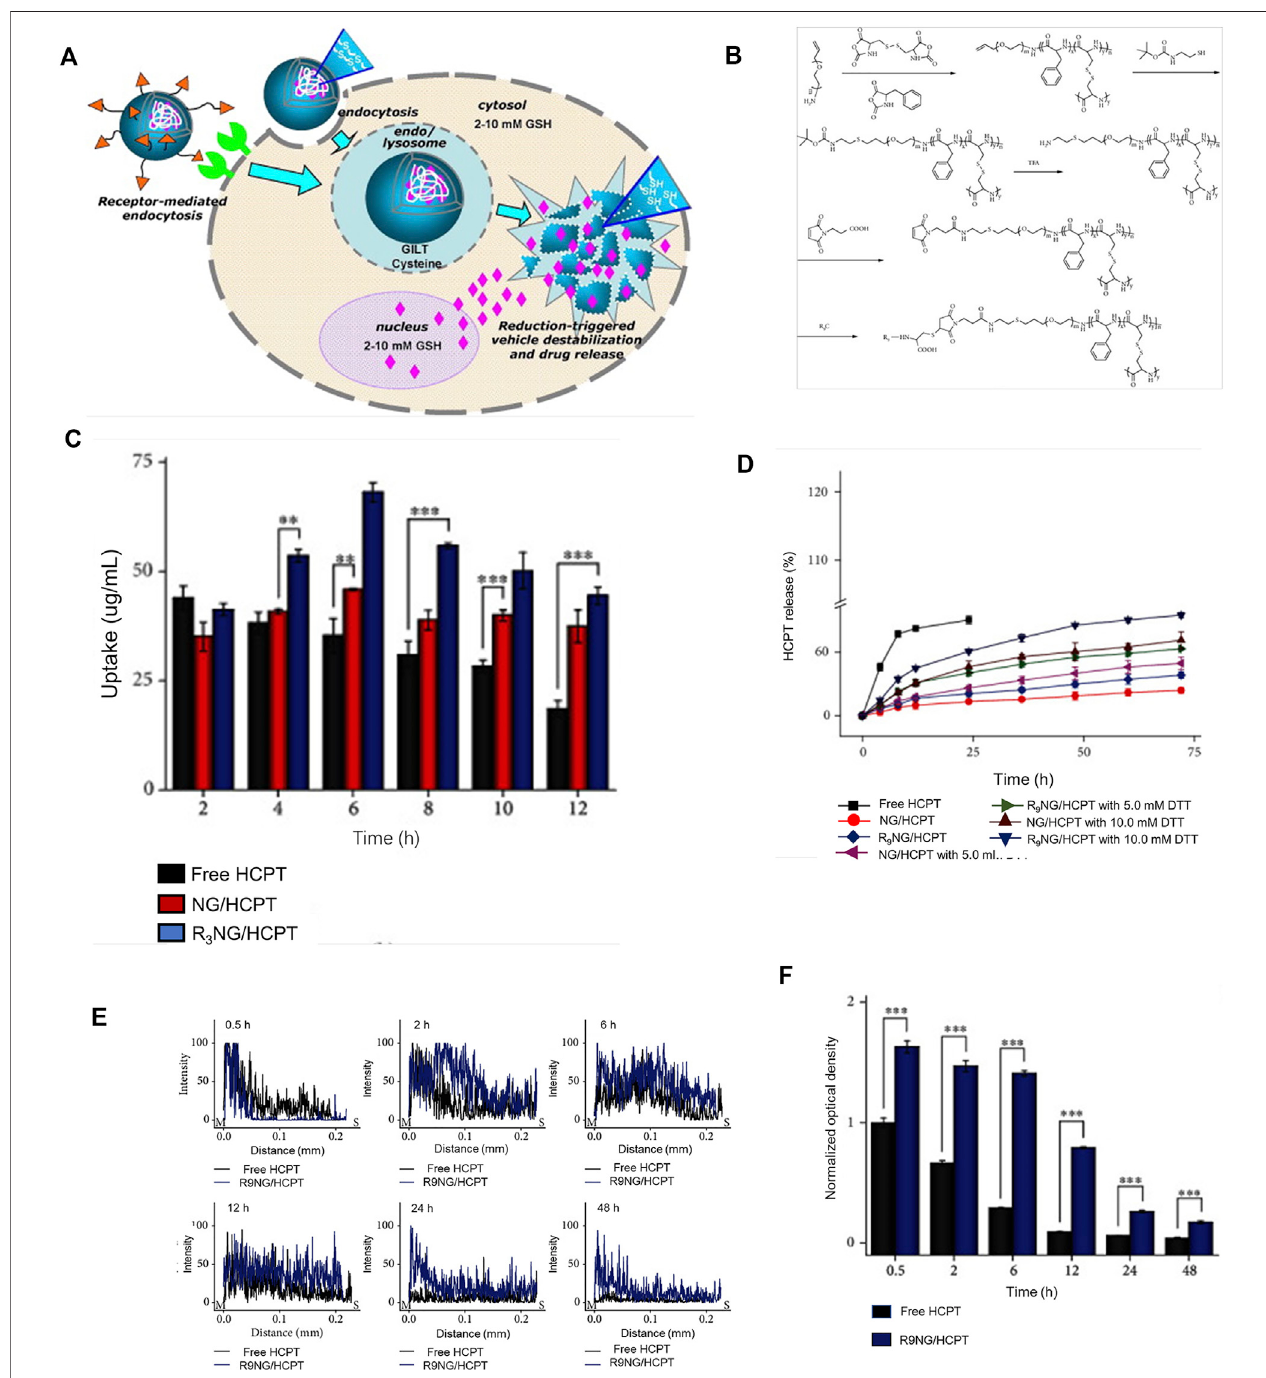
FIGURE 4 | Reduced responsive nanoparticles as carriers for intracellular drug release. (A) Schematic illustration of reduced responsive nanoparticle carriers for intracellular drug release (Cheng et al., 2011). (B) Synthesis route of R9-PEG – P (LP-co-LC). (C) Intracellular HCPT release in human BC 5637 cells treated with different formulations of HCPT. (D) In vitro release pro fi les of R9NG/HCPT. (E) Quanti fi cation of bladder penetration of HCPT based on fl uorescence intensity. (F) Quantitative analysis of fl uorescence intensity of HCPT. Reproduced with permission from (Guo et al., 2020).